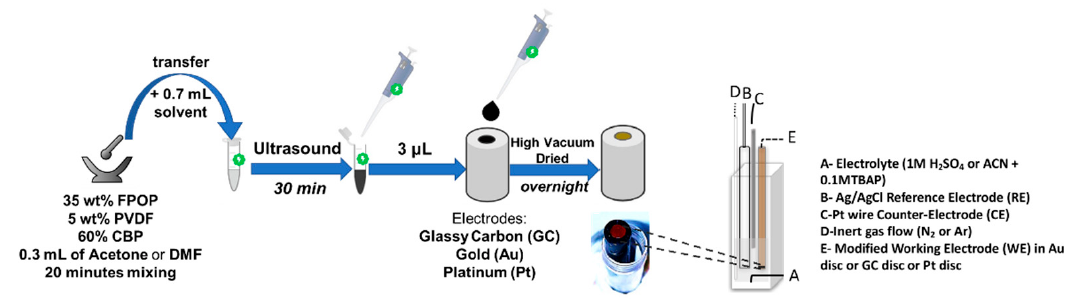
Table 1. Standard potential, anodic peak potential (in mV vs. SCE) and Δ E p for ferrocene and FPOP modified electrodes in different solvents at 20 °C.